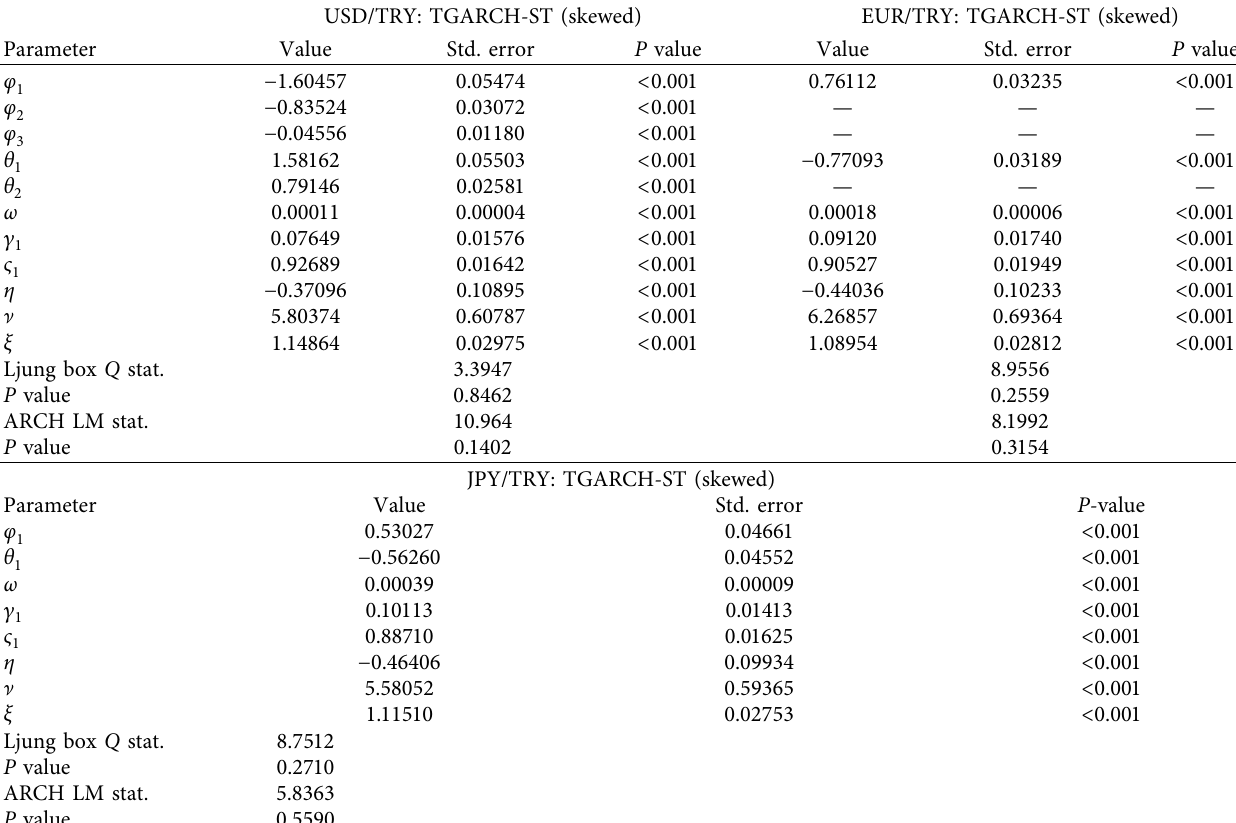
Table 3: Parameter estimations for marginal distributions and statistical test. USD/TRY: TGARCH-ST (skewed) EUR/TRY: TGARCH-ST